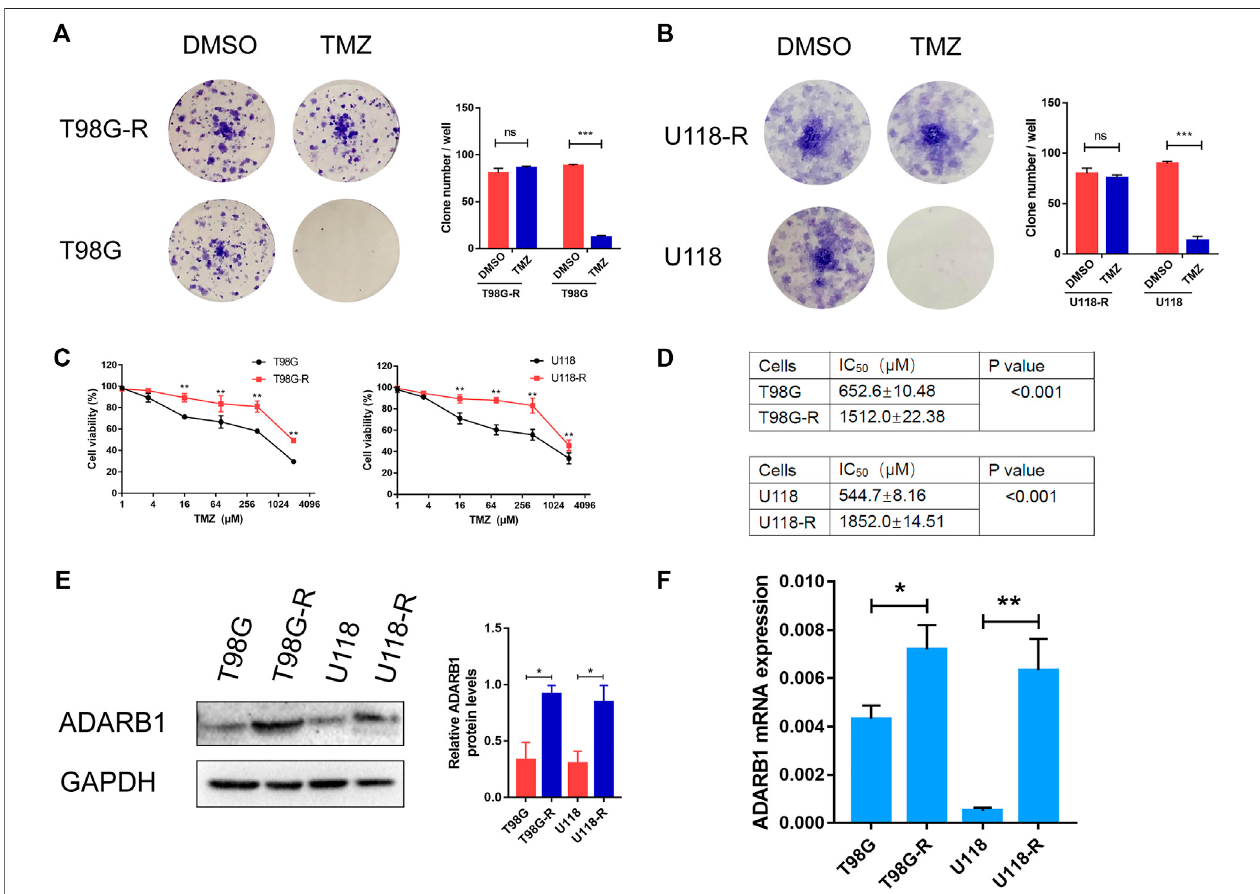
FIGURE 2 | ADARB1 involved in TMZ resistance in glioma cells. (A,B) Establishment of TMZ-resistant glioma cells in T98G and U118 cells. Compared with T98G and U118cells, T98G-R and U118-RcellswereremarkablymoreresistanttothetreatmentofTMZin colonyformation assay. (C,D) Cell viabilityanalysiswasperformed to evaluate cytotoxicity of TMZ to T98G, T98G-R, U118, and U118-R cells under treatment with the indicated concentrations of TMZ for 72 h (E,F) The protein and mRNA expression levels ofADARB1were signi fi cantlyhigher inT98G-R and U118-Rcells,respectively. Theresults werepresentedasmeans±SD ( n =3foreach panel). Statistical signi fi cance was concluded at * p < 0.05. (G) Western blot for ADARB1 expression in T98G-R and U118-R cells treated with siCtrl or siADARB1. (H,I) T98G-R and U118-R cells transfected with siADARB1 or siRNA combined with TMZ treatment were subjected to MTS assays and colony formation assays. (J)